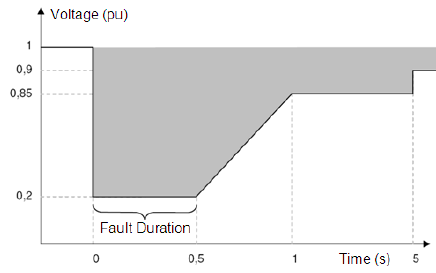
Figure 1. Ride ‐ through fault capability (RTFC) required by Brazilian grid code [3].